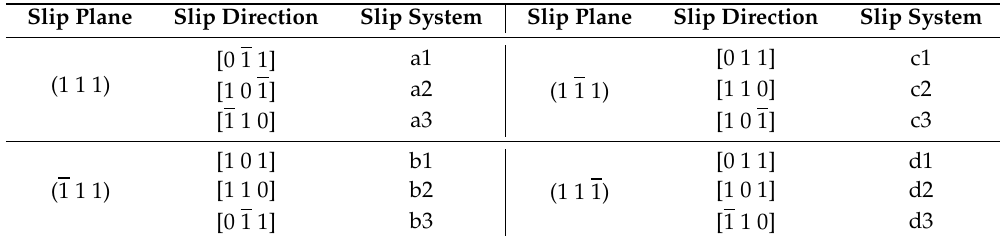
Table 3. Slip systems of face-centered cubic FCC metal.